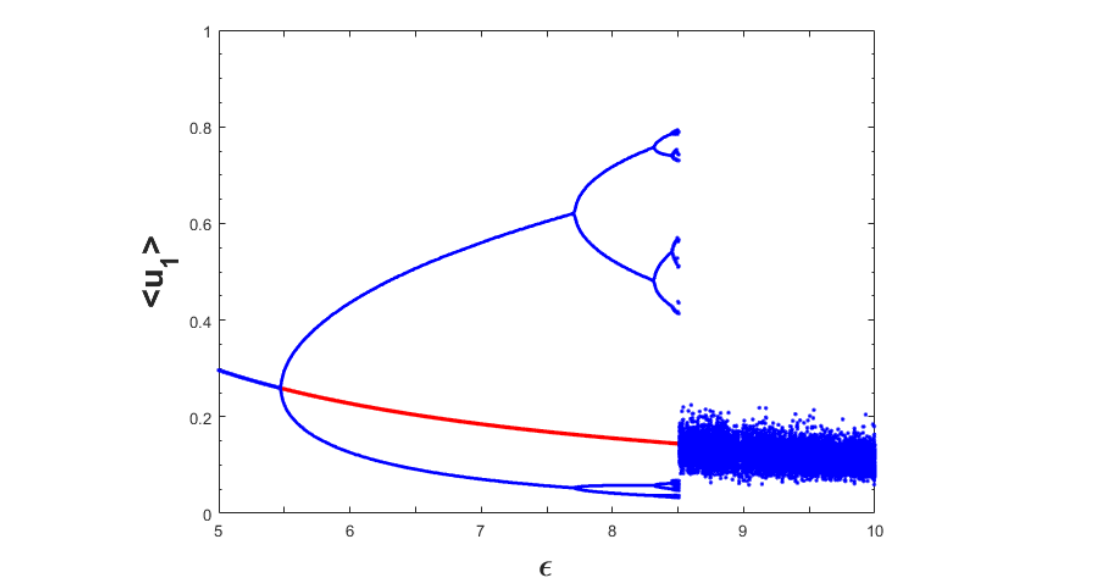
Figure 11. Single parameter bifurcation diagram for the spatially averaged density of first prey population ( < u 1 > ) with respect to the parameter (cid:101) for the spatiotemporal model (11)–(13). Here, we have used pulse type initial population distributions for each value of (cid:101) . Other parameter values are mentioned in (25) with d 3 = 1.0.